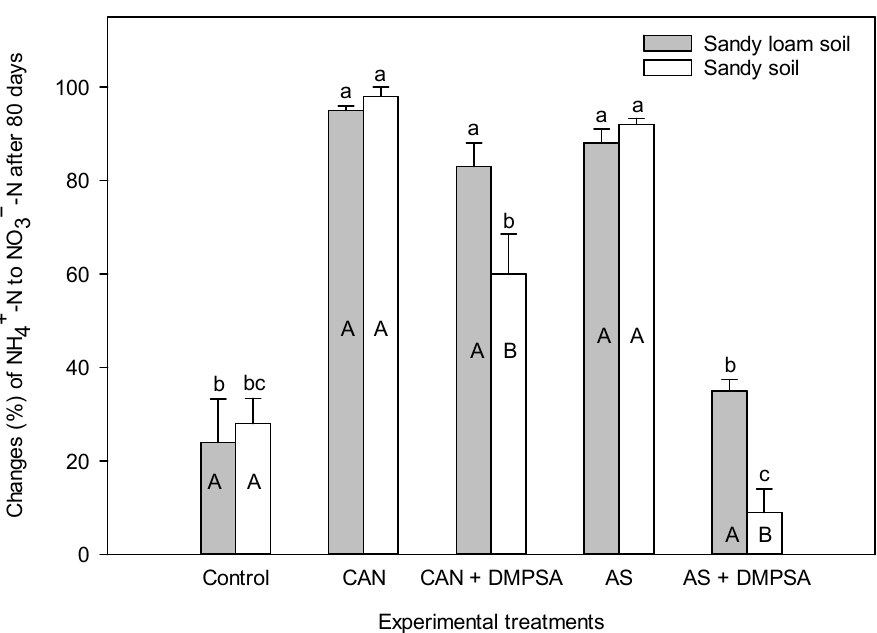
Figure 2. Change (%) in NH 4+ -N to NO 3 − -N (%) at the end of an 80-day incubation period in a sandy loam and a sandy soil. Different lower case letters indicate a significant difference ( p ≤ 0.05) between different treatments within a soil type. Mean comparison based on the F-protected LSD test ( p ≤ 0.05).